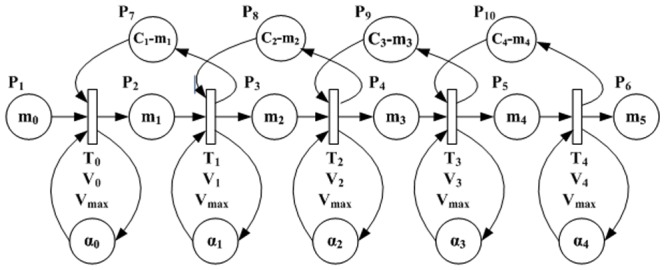
VCPN traffic model.